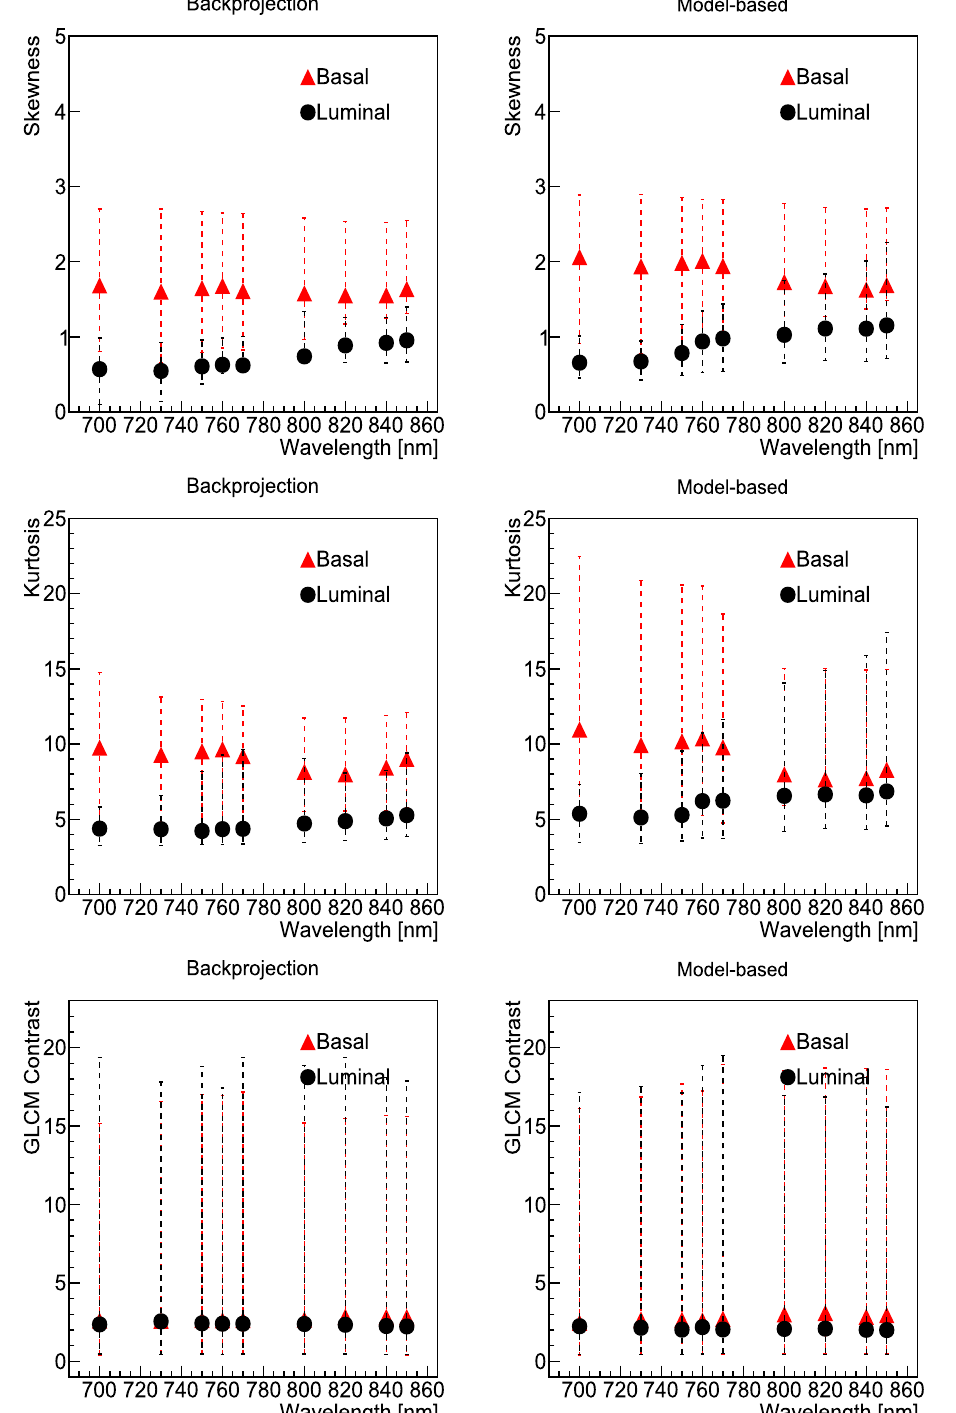
Figure 5. Median (markers) and IQR (lines) of the values of the selected radiomic features: first-order Skewness (top row), first-order Kurtosis (middle row) and GLCM Contrast (bottom row). Values are shown for each model independently, with basal PDX in red and luminal B PDX in blue, as a function of the wavelength used, with backprojection reconstruction on the left and model-based reconstruction on the right. All grey level quantisations were used in each